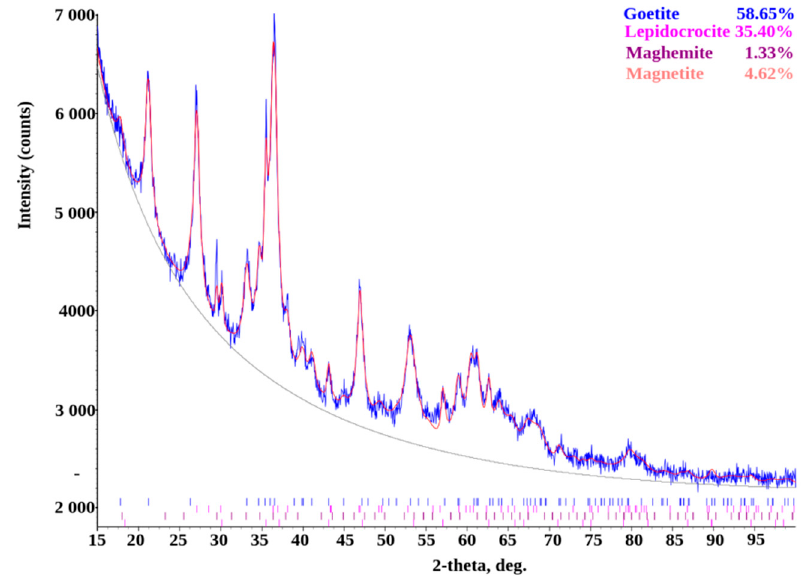
Figure 9. Diffractogram of the St3 surface compounds. Vertical bars at the bottom of the graph mark the peak positions of the identified phases.